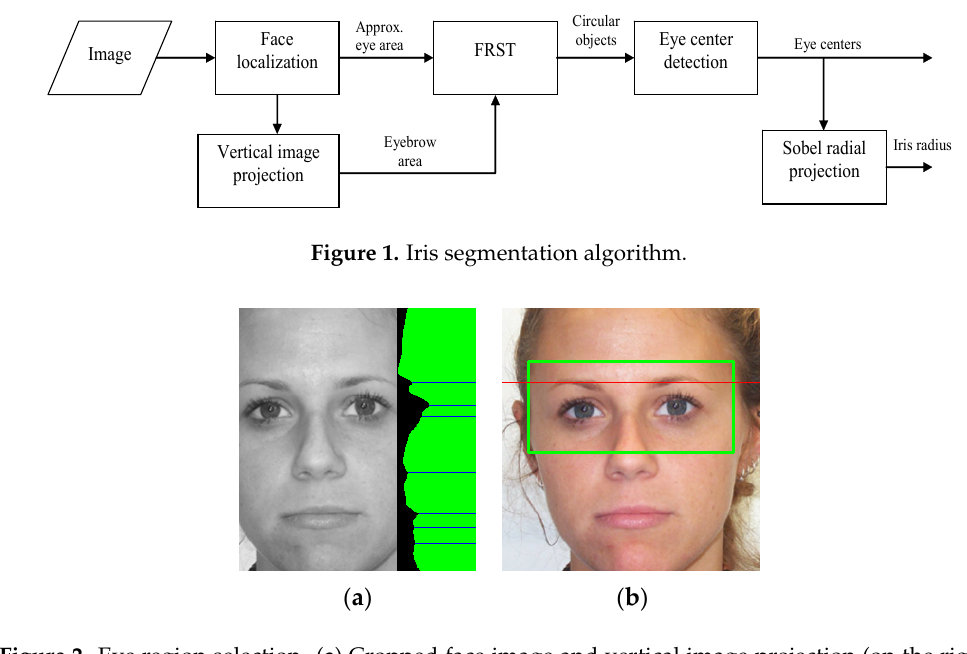
Figure 1. Iris segmentation algorithm.